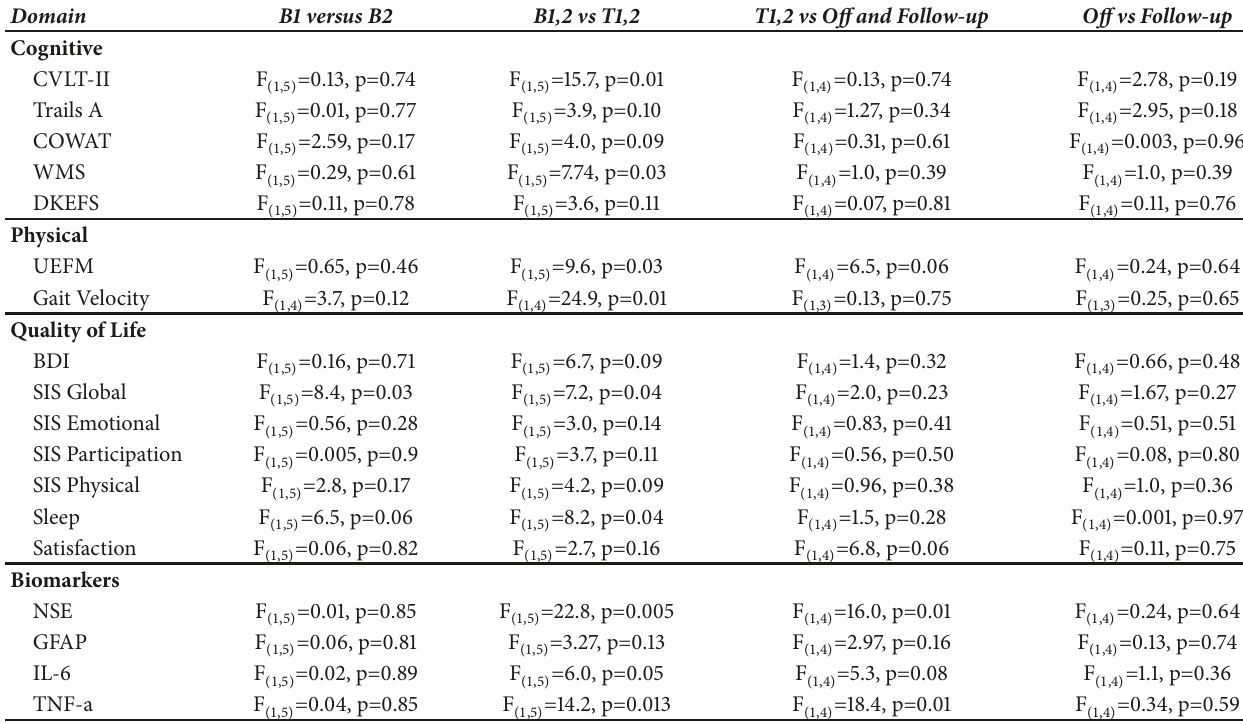
Table 3: Effect of HBOT on functional impairments: repeated measures